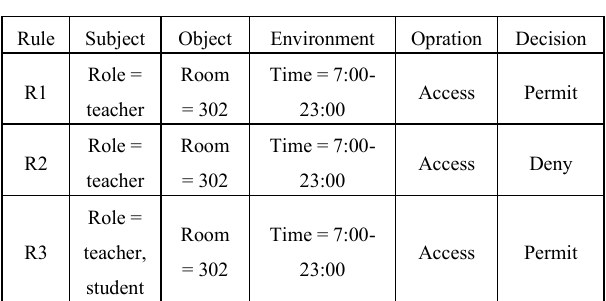
Figure 4. The index structure of object attrib utes. Conflict Detection